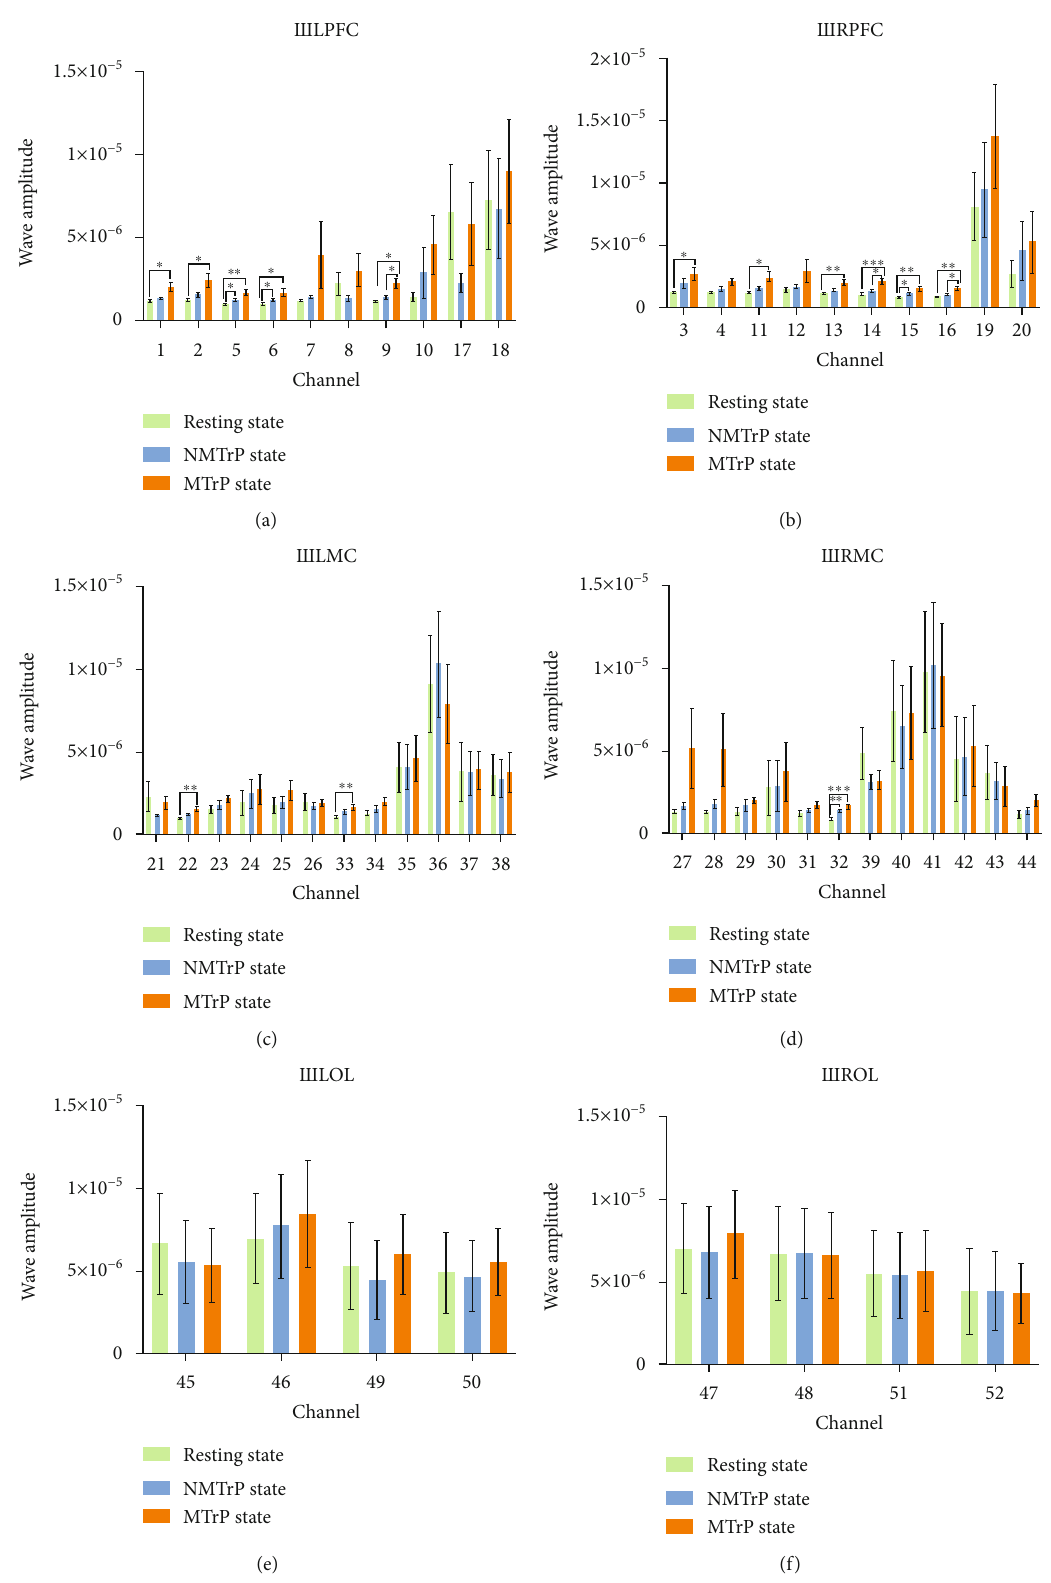
Figure 3: Comparison of wavelet amplitude (WA) changes among three stages in the frequency interval III: PFC (a and b), MC (c and d), and OL (e and f). Error bars are mean ± s : e : m : ∗ : p < 0 : 05 ; ∗∗ : p < 0 : 01 ; ∗∗∗ : p < 0 : 001 . MTrP: myofascial trigger point; NMTrP: nonmyofascial trigger point; L: left; R: right; PFC: prefrontal cortex; MC: motor cortex; OL: occipital